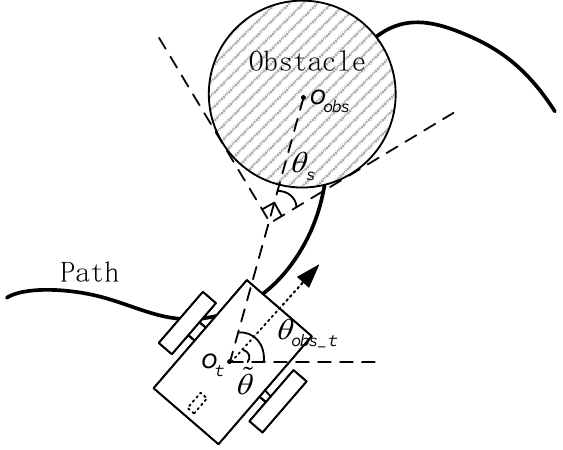
Figure 3. Obstacle avoidance illustration for a NWMR for path-following.